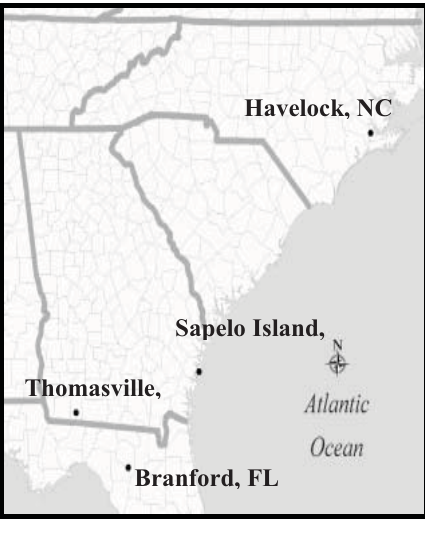
Figure 11. Distribution map of locales where the new species, Reticulitermes nelsonae have been collected